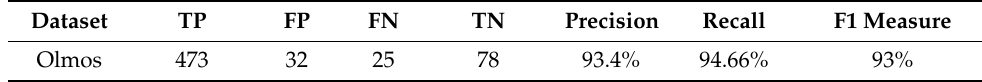
Table 4. Results obtained by classification model on Olmos test set.